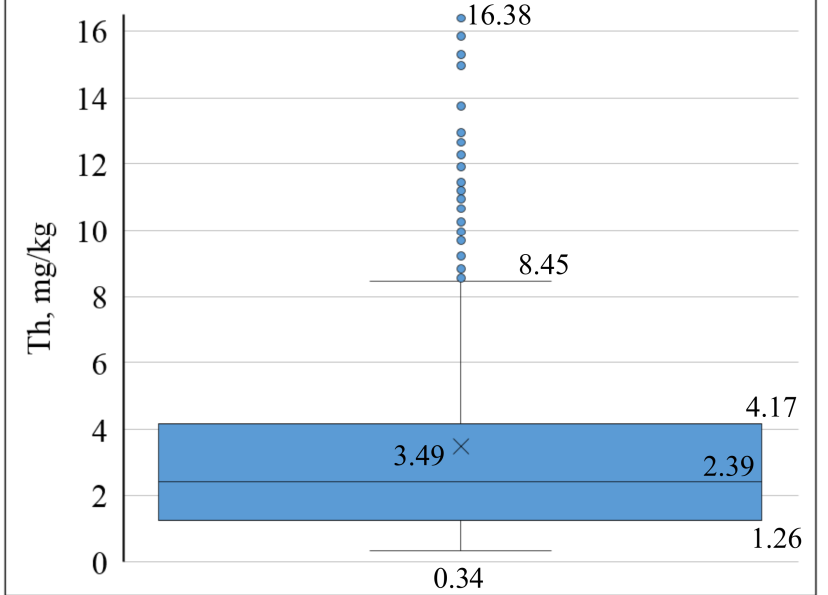
Figure 7. Variation of Th concentration in the sediments of lakes in the Republic of Karelia with the main statistical parameters; from bottom to top: the minimum value of the sample, the lower quartile (25th percentile), the median, the arithmetic mean (indicated by a cross), the upper quartile (75th percentile), the maximum value of the sample, the extremely high values that stand out from the total sample (indicated by circles).